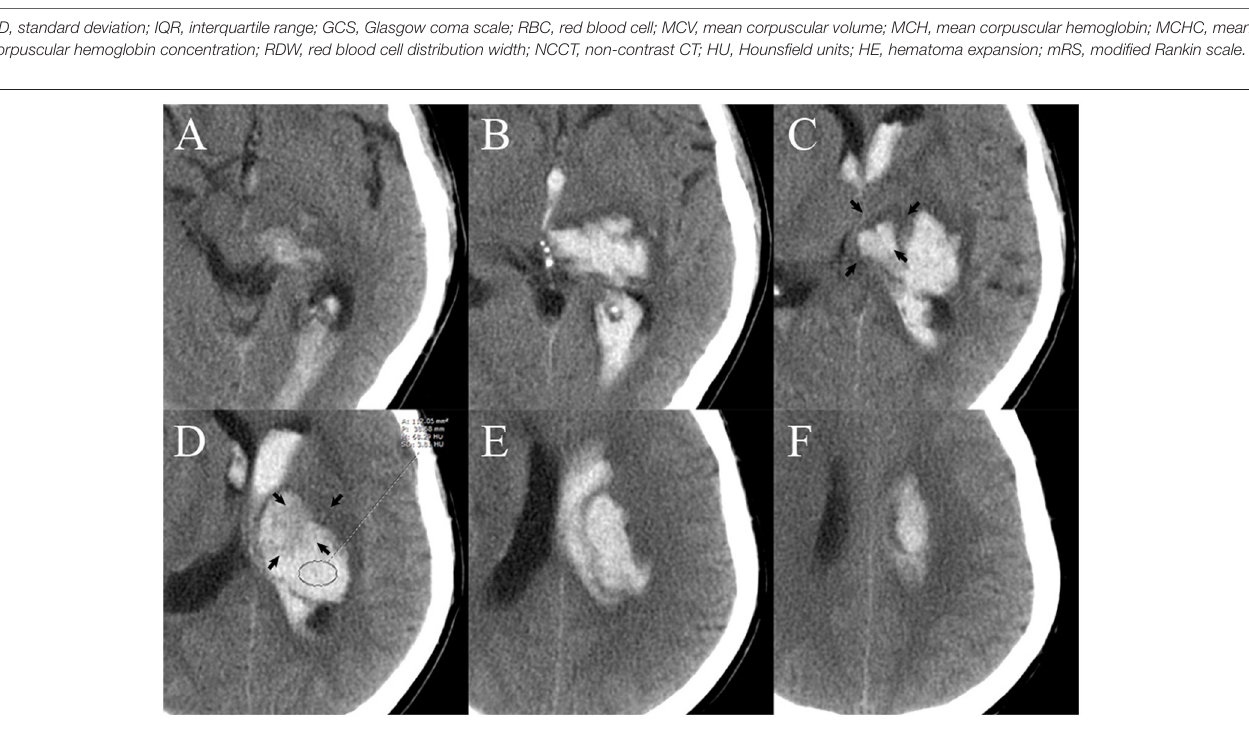
FIGURE 2 | Measurement of the attenuation value of the region of interest (ROI) of the non-hyperdense region of the hematoma. There are six layers of hematoma on axial NCCT images. The upper (A,B) and lower layers (E,F) are not suitable for measurement because they are adjacent to normal brain tissue. The core two layers (C,D) are selected as the best layer for measurement. The area of layer (D) (black arrow) that is adjacent to normal tissue [layer (C) , black arrow] may cause partial volume effects that affect the accuracy of the measurement and is therefore excluded from the ROI. A, area; P, perimeter; M, mean; SD, standard deviance; HU, Hounsfield units; NCCT, non-contrast computed